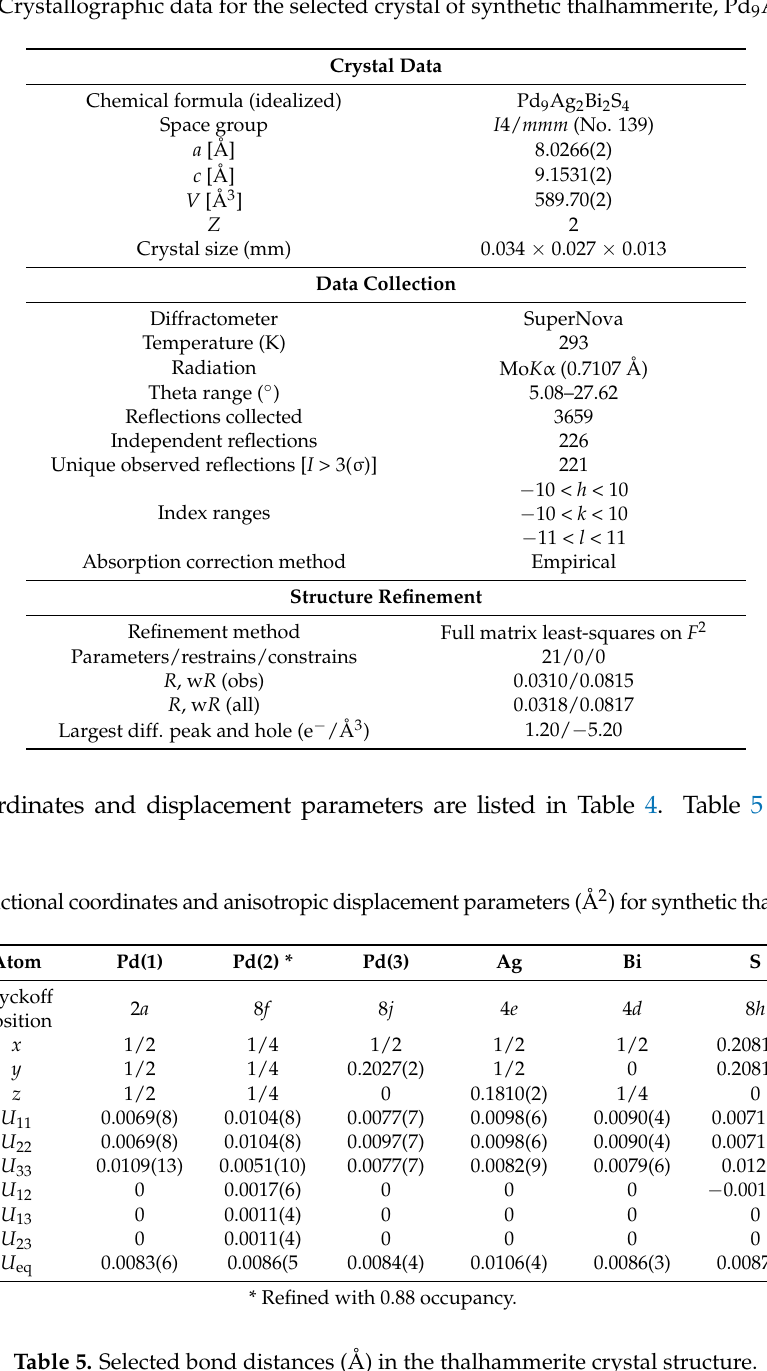
Table 3. Crystallographic data for the selected crystal of synthetic thalhammerite, Pd 9 Ag 2 Bi 2 S 4 .